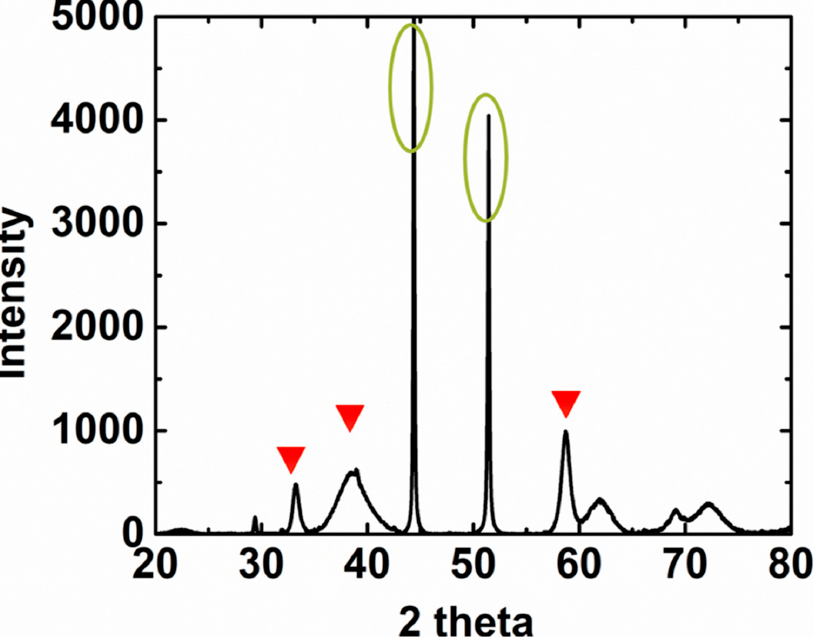
Figure 1. X-ray diffraction (XRD) results (WL = 1.54 Ǻ ) for Ni (OH) 2 on the Ni sheet; :Ni(OH) 2 ;